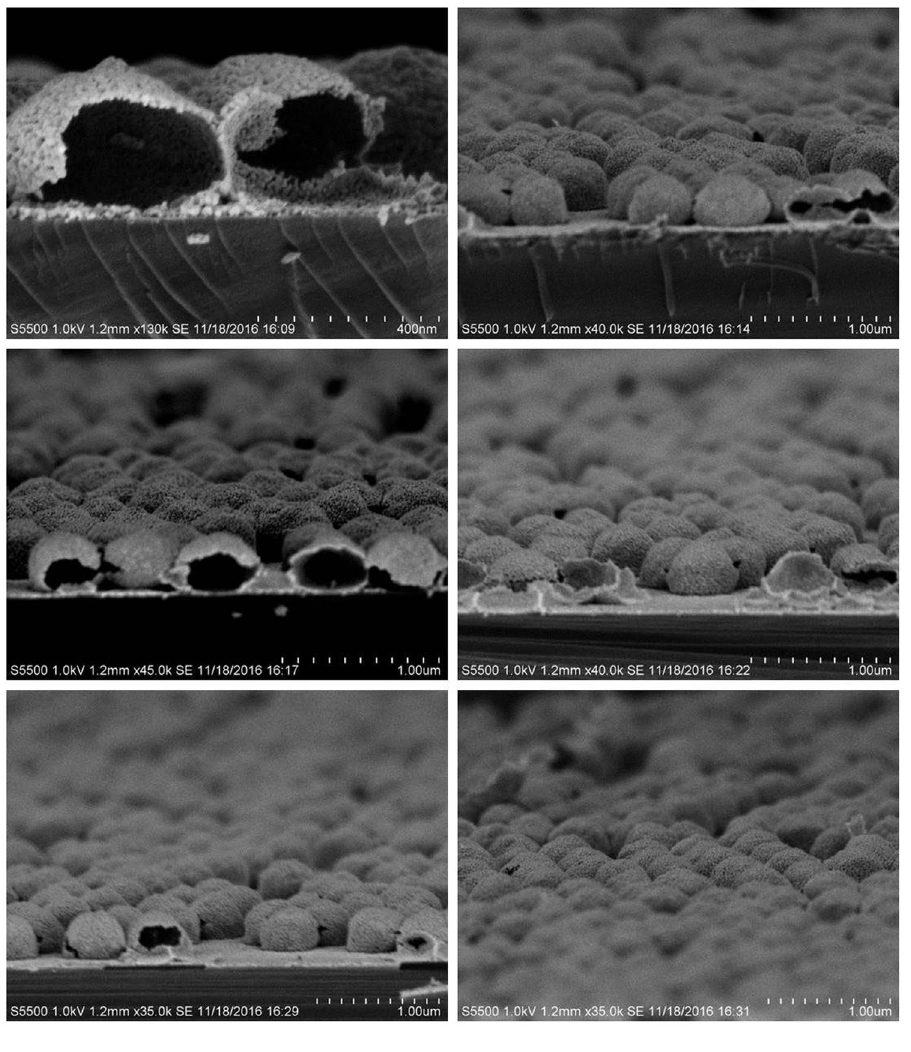
Figure 4. FE-SEM images of the spherical nanoshell structures after the removal of the PS spheres (i.e. annealed at 500 °C for 30 minutes in air). The samples are deposited on both Si (100) and quartz substrates. The SEM images show 90° view of the Z_NS structures at different positions, with clear evidence of internal voids following PS sphere removal.